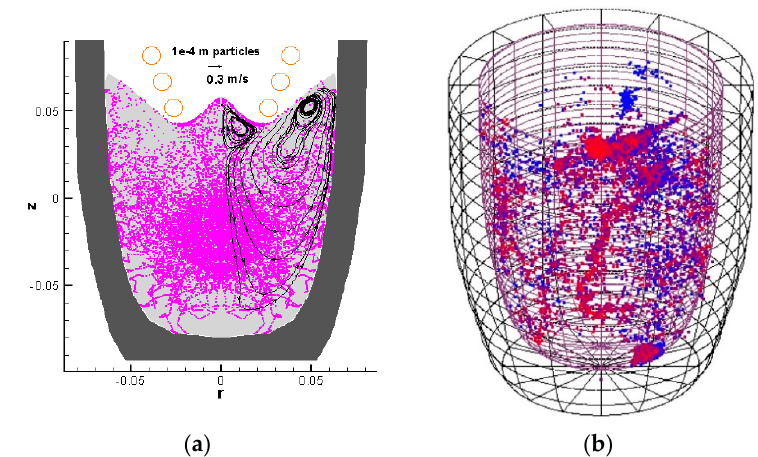
Figure 5. PEPT experiment, 125 mm crucible: ( a ) Simulation result showing dispersion of 100 μ m particles due to induction stirring, ( b ) experimental 200 μ m radioactive particle traces obtained using the PEPT technique.